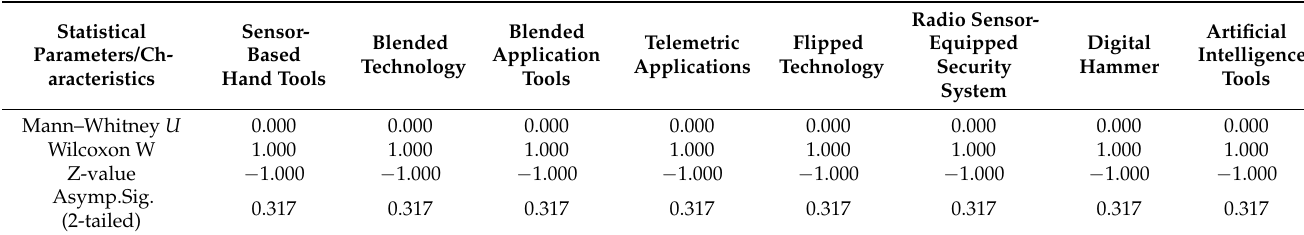
Table 12. Wilcoxon and Mann–Whitney U statistical test